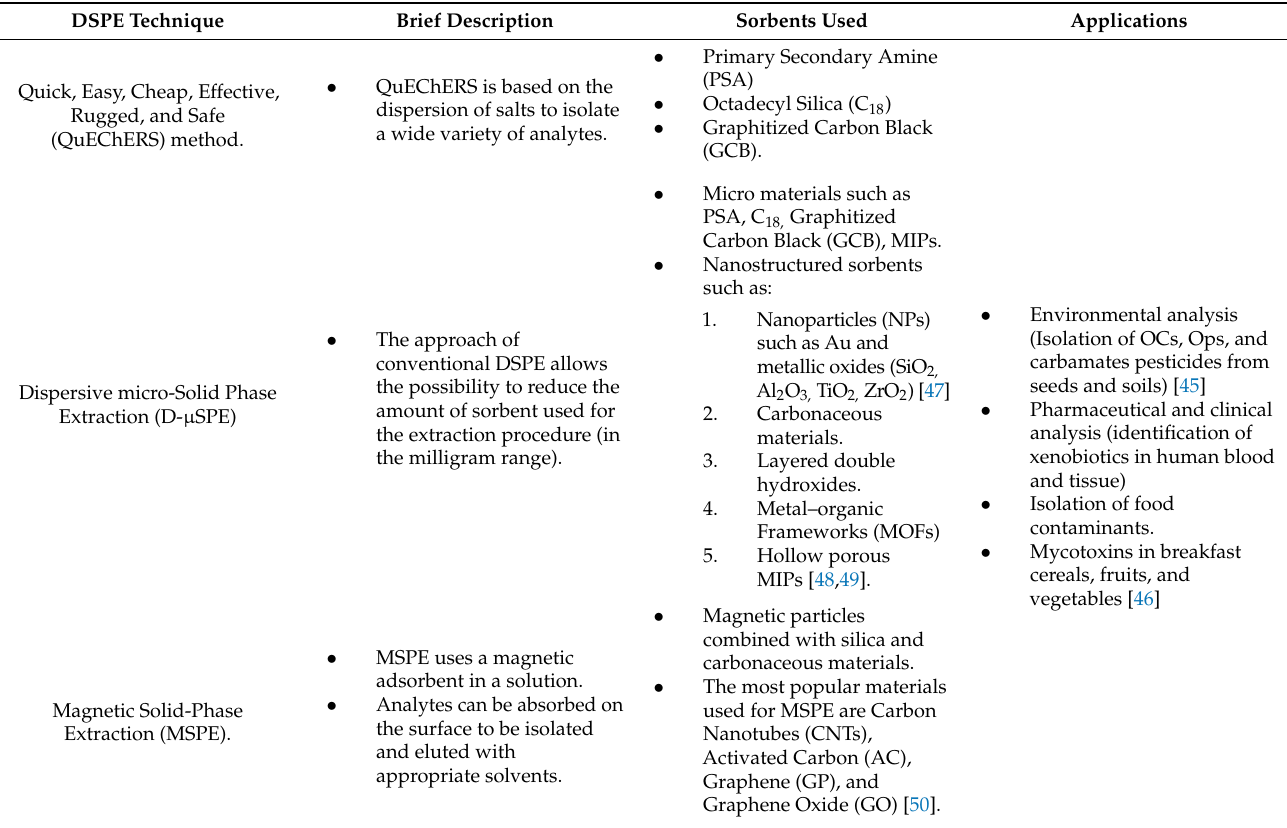
Table 6. Information on the DSPE procedures used for analytical